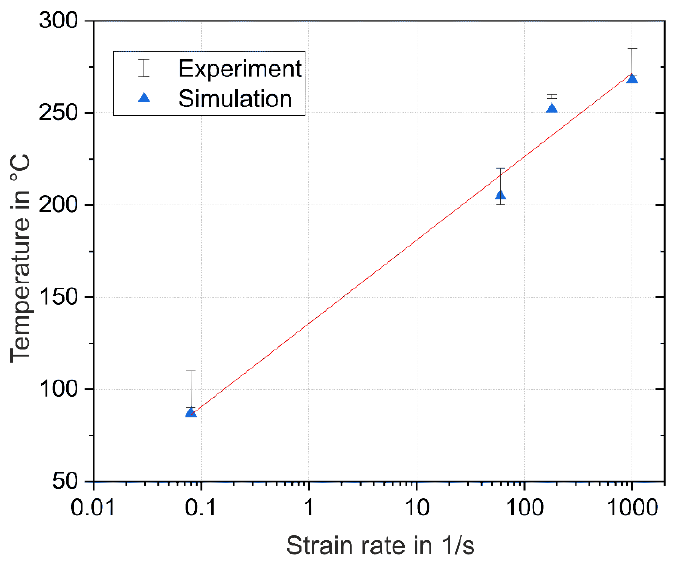
Figure 15. Comparison of experimentally measured temperature values and simulation results for actual strain rates of 0.08/s, 60/s, 180/s, and 700/s.